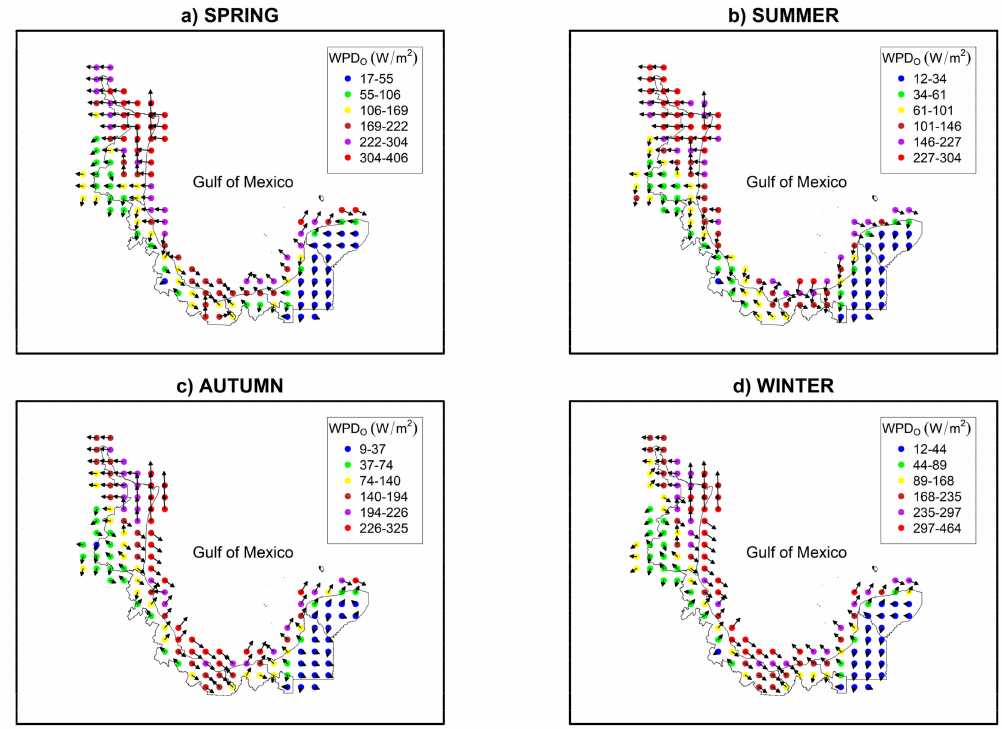
Figure 10. Seasonal prevailing wind direction and its WPD O along the states of the Gulf of